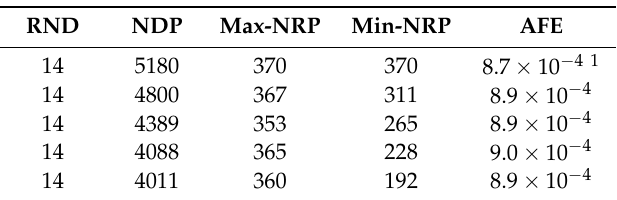
Table 3. Experiment results of example 5. Max-NRP and Min-NRP are the maximum and minimum number of data points in each row of the scattered data. The meanings of the other abbreviations are the same as Table